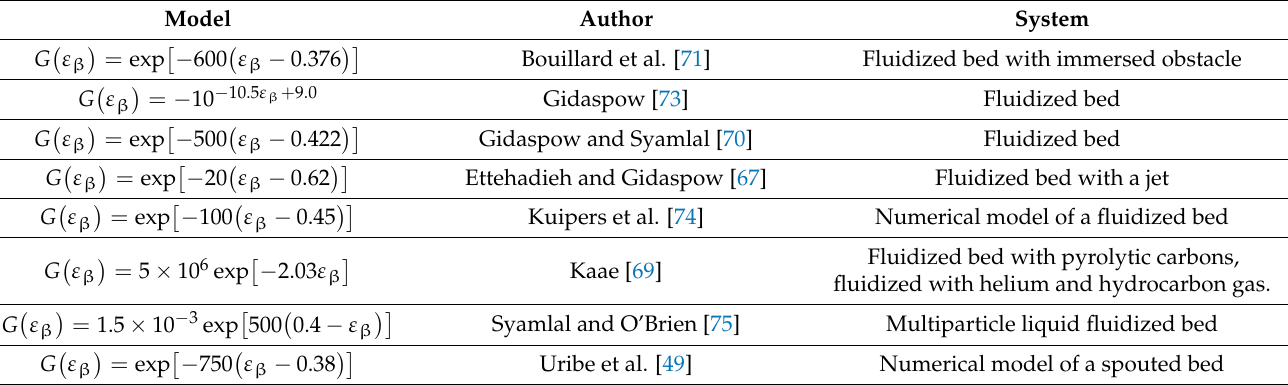
Table 1. Commonly reported Modulus of Elasticity